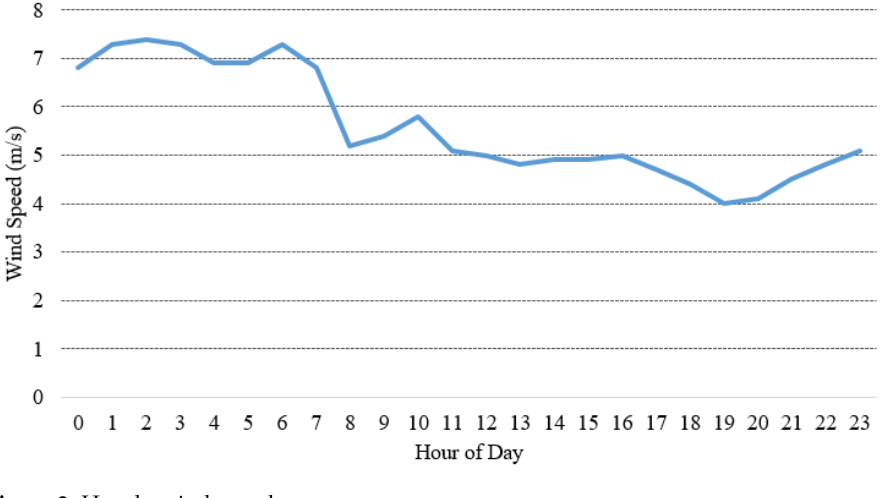
Figure 3. Hourly wind speed. Table 3. Wind turbine